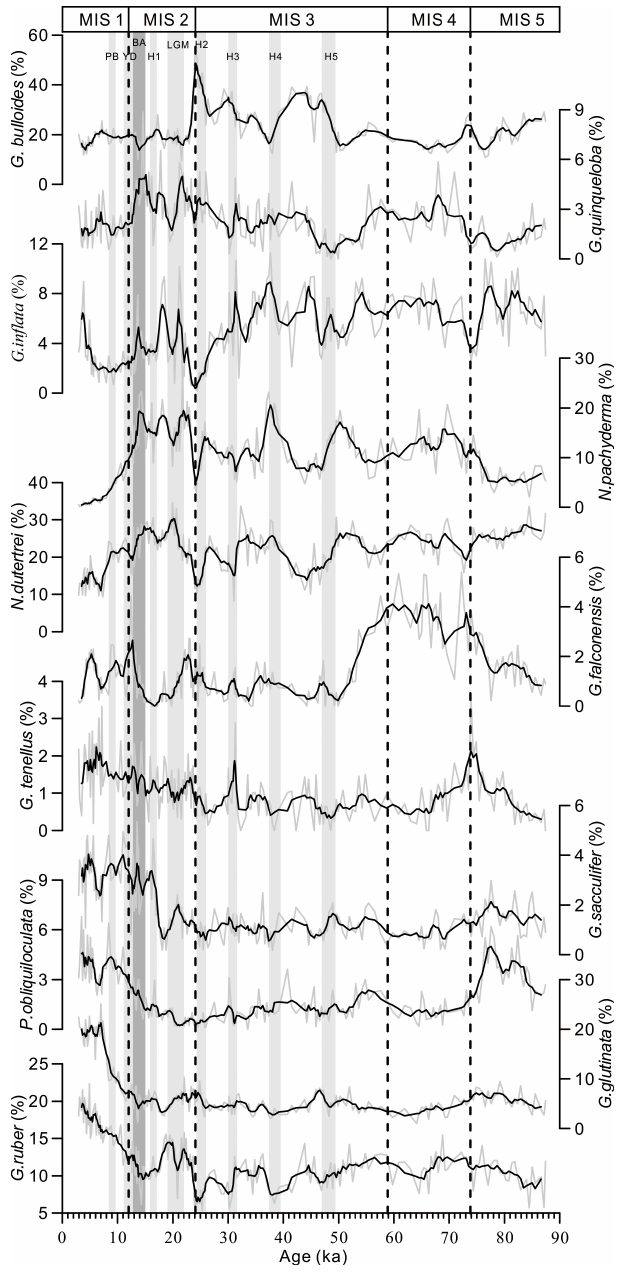
Figure 5. Time series plots for the abundances of dominant species of planktonic foraminifera in core CSH1. Gray bars are the same as those in Fig.